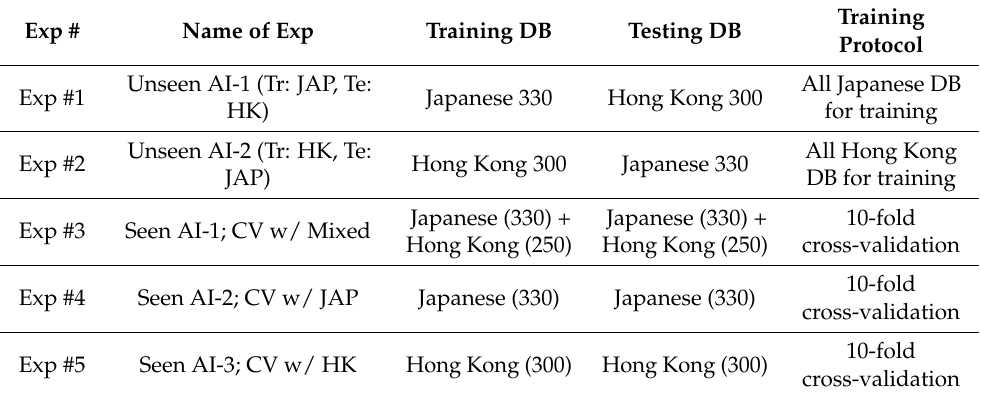
Table 1. Summary of all experiments performed on a multiethnic